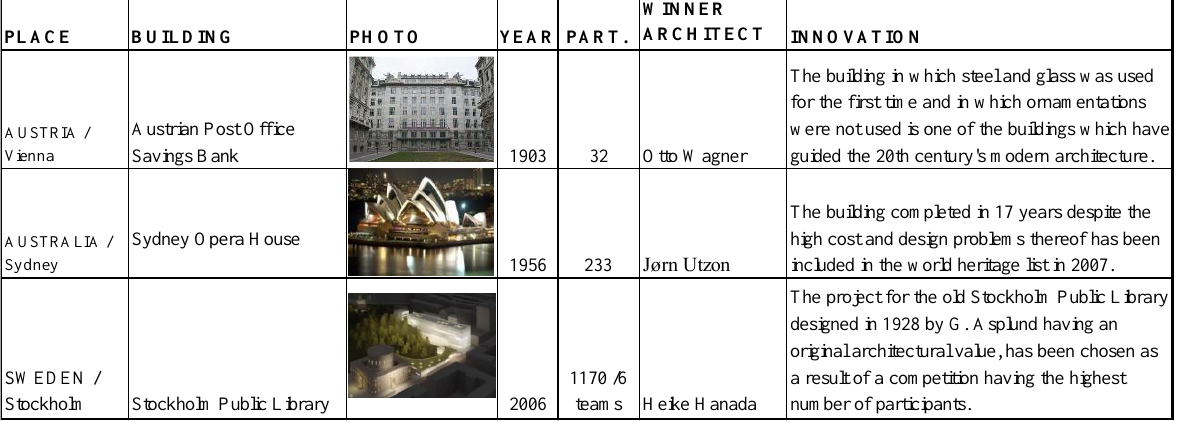
Table 5. Selected competition examples from Austria, Australia and